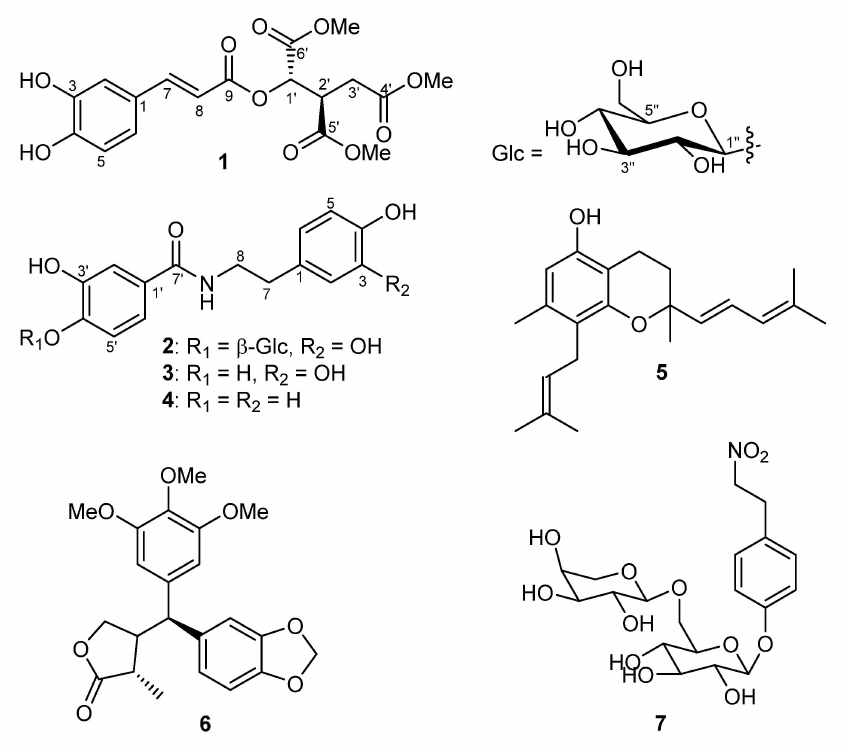
Figure 1. Chemical structures of compounds 1 – 7